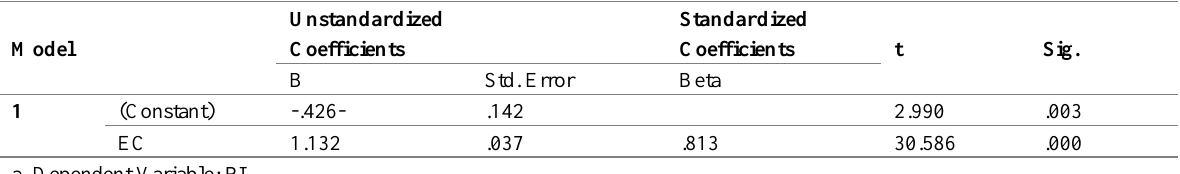
Table 13: Results of Linear Regression between Economic and Purchase Intention 20